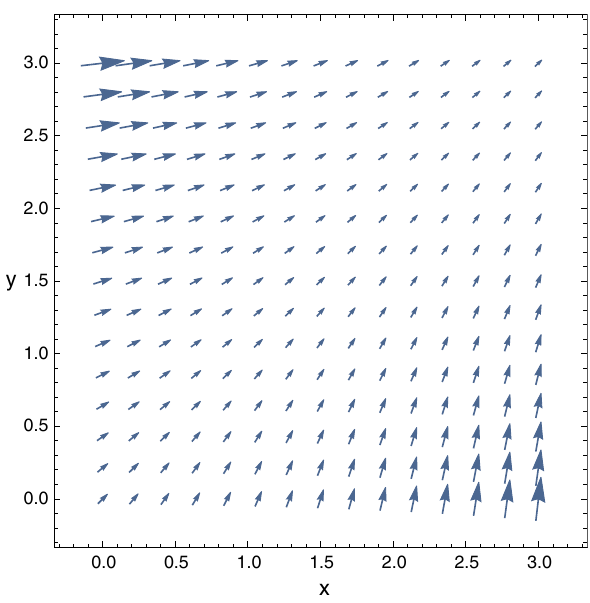
Fig. 1 This vector plot illustrates the spatial (non-linear) polarization pattern on the ( x , y ) plane for the electric field at a given instant. This pattern is exclusively induced by the GW. The GW parameters are a = 0 . 036, b = 0 . 766, w/ 2 π = 89 . 81 Hz, α = 0 . 11 π . We have used Eqs. (3.30) and (3.31), where for simplicity we assumed ˜ C 1 ( z , t ) = ˜